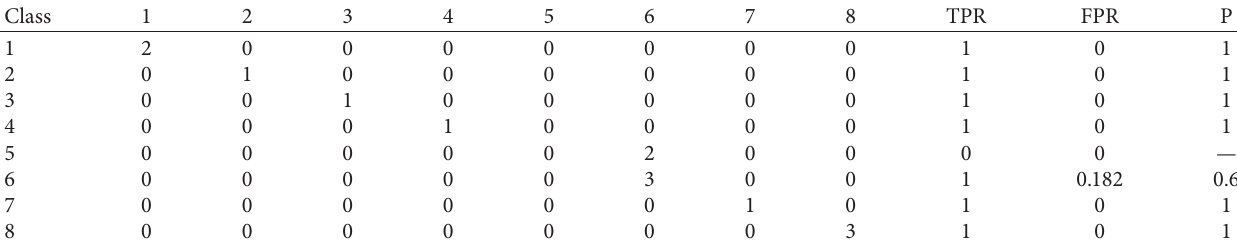
Table 17: Confusion matrix, TP rate (TPR), FP rate (FPR), and precision (P) for each test instance.